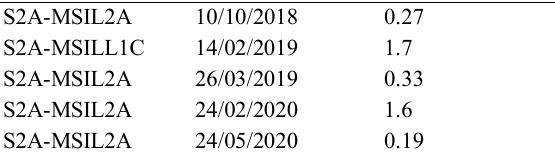
Table 1 . Sentinel-2 images downloaded.